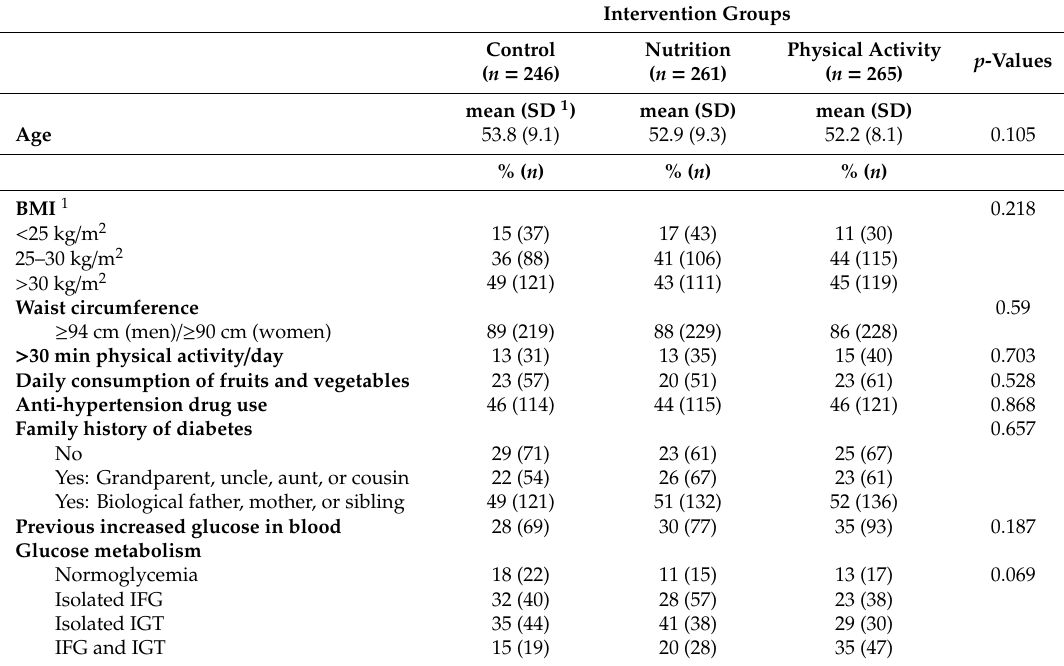
Table 1. Baseline characteristics of the study participants after